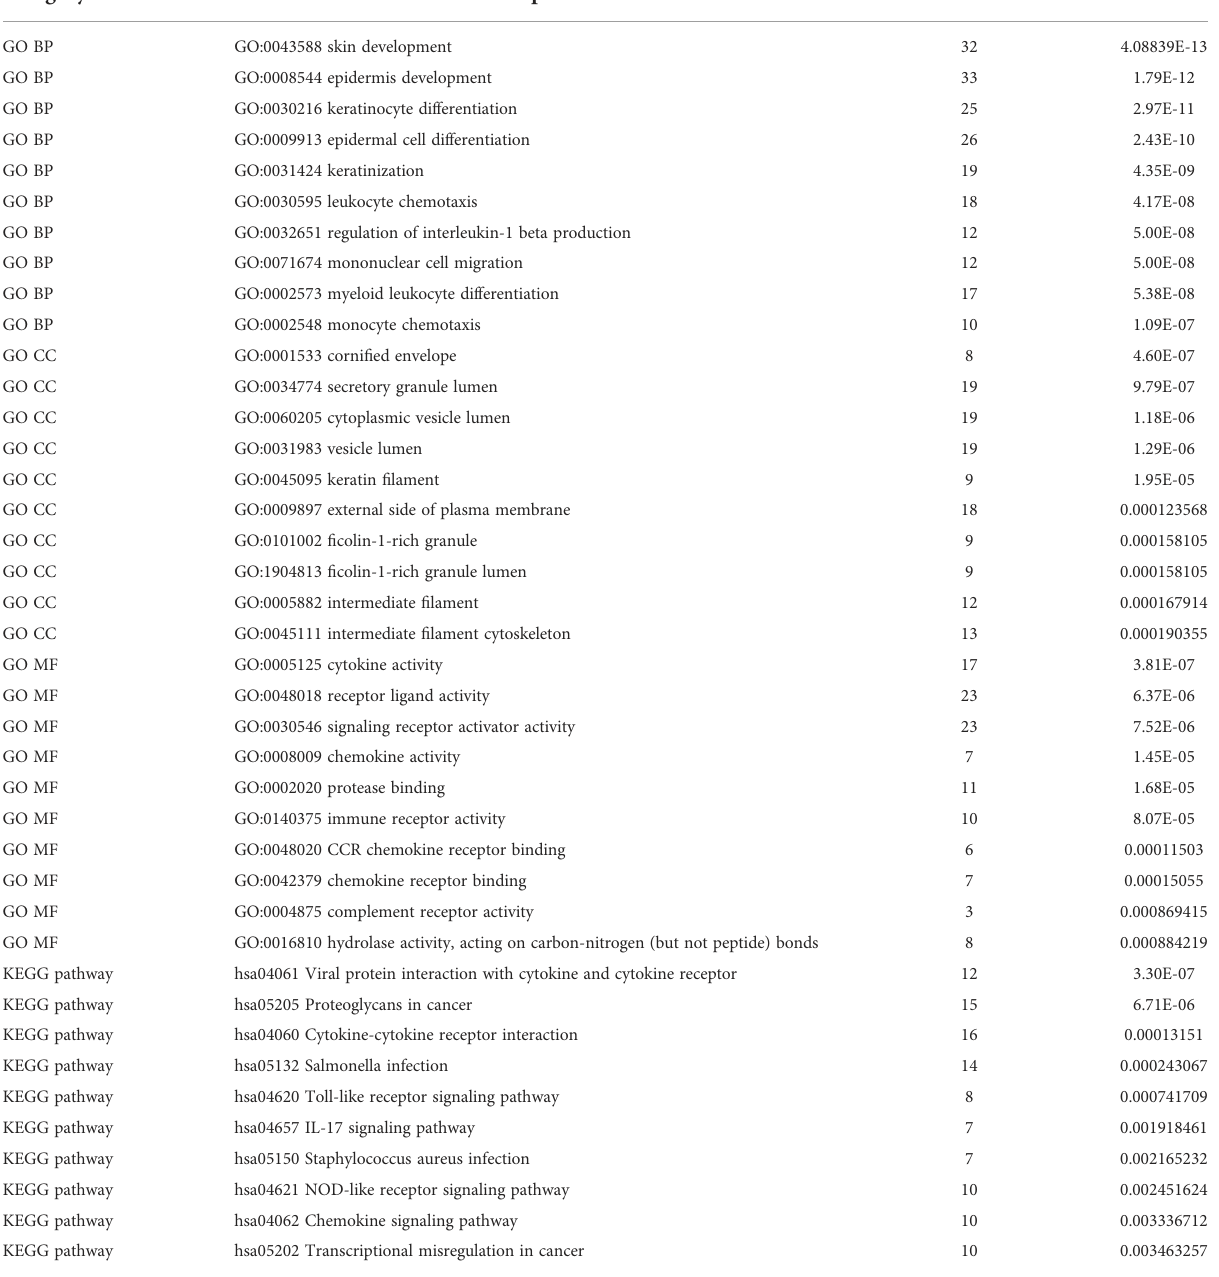
TABLE 2 The top 10 items of genes enrichment of the shared